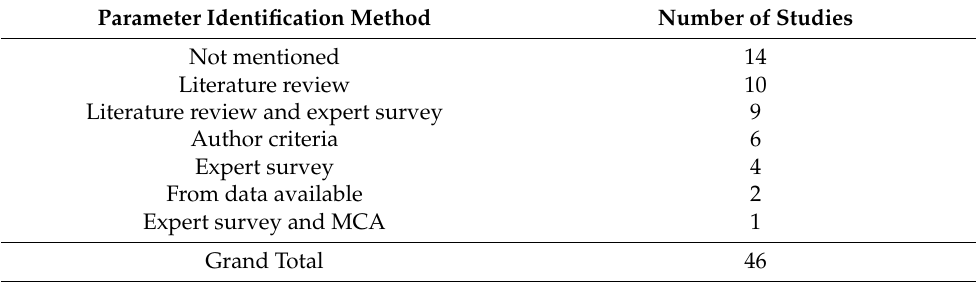
Table 2. Number of methods to identify the parameters.